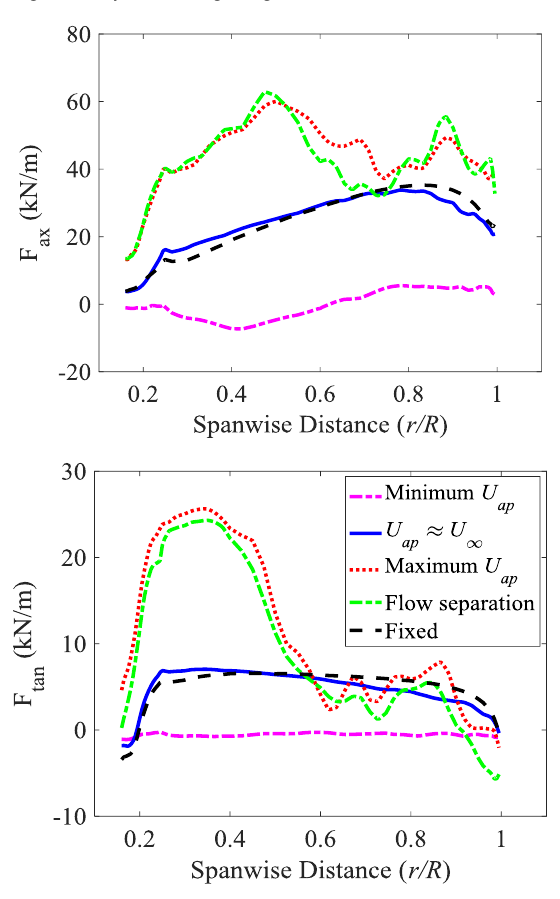
Fig. 13. Axial and tangential force profiles along the blade for fixed and surging turbine ( 𝐴 ∗ = 0.15) corresponding to the minimum 𝑈 𝑎𝑝 , 𝑈 𝑎𝑝 ≈ 𝑈 ∞ , maximum 𝑈 𝑎𝑝 , and when the most significant flow separation